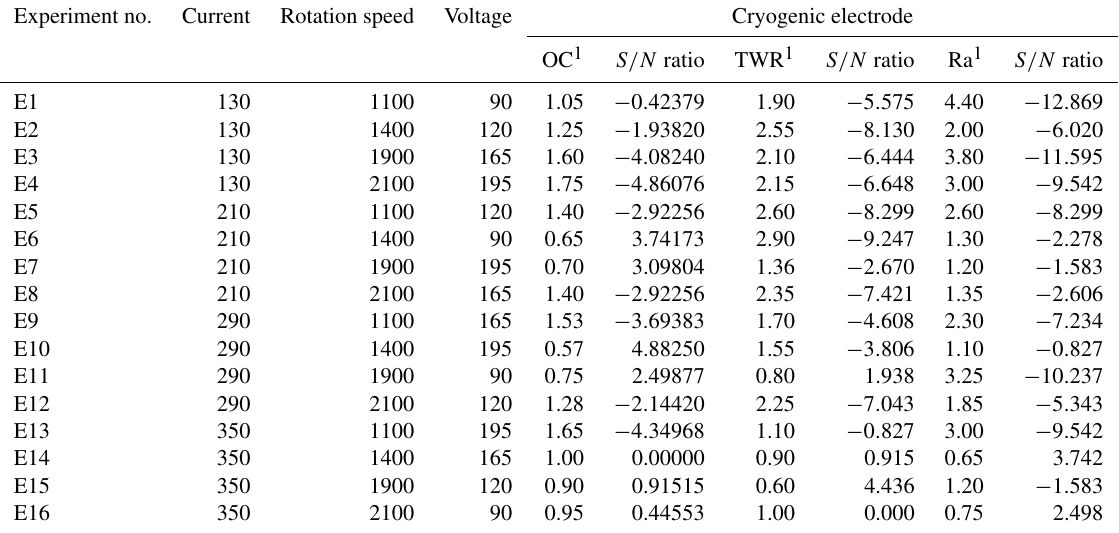
Table 5. Orthogonal array with performance for deep cryogenic electrode. Experiment no.